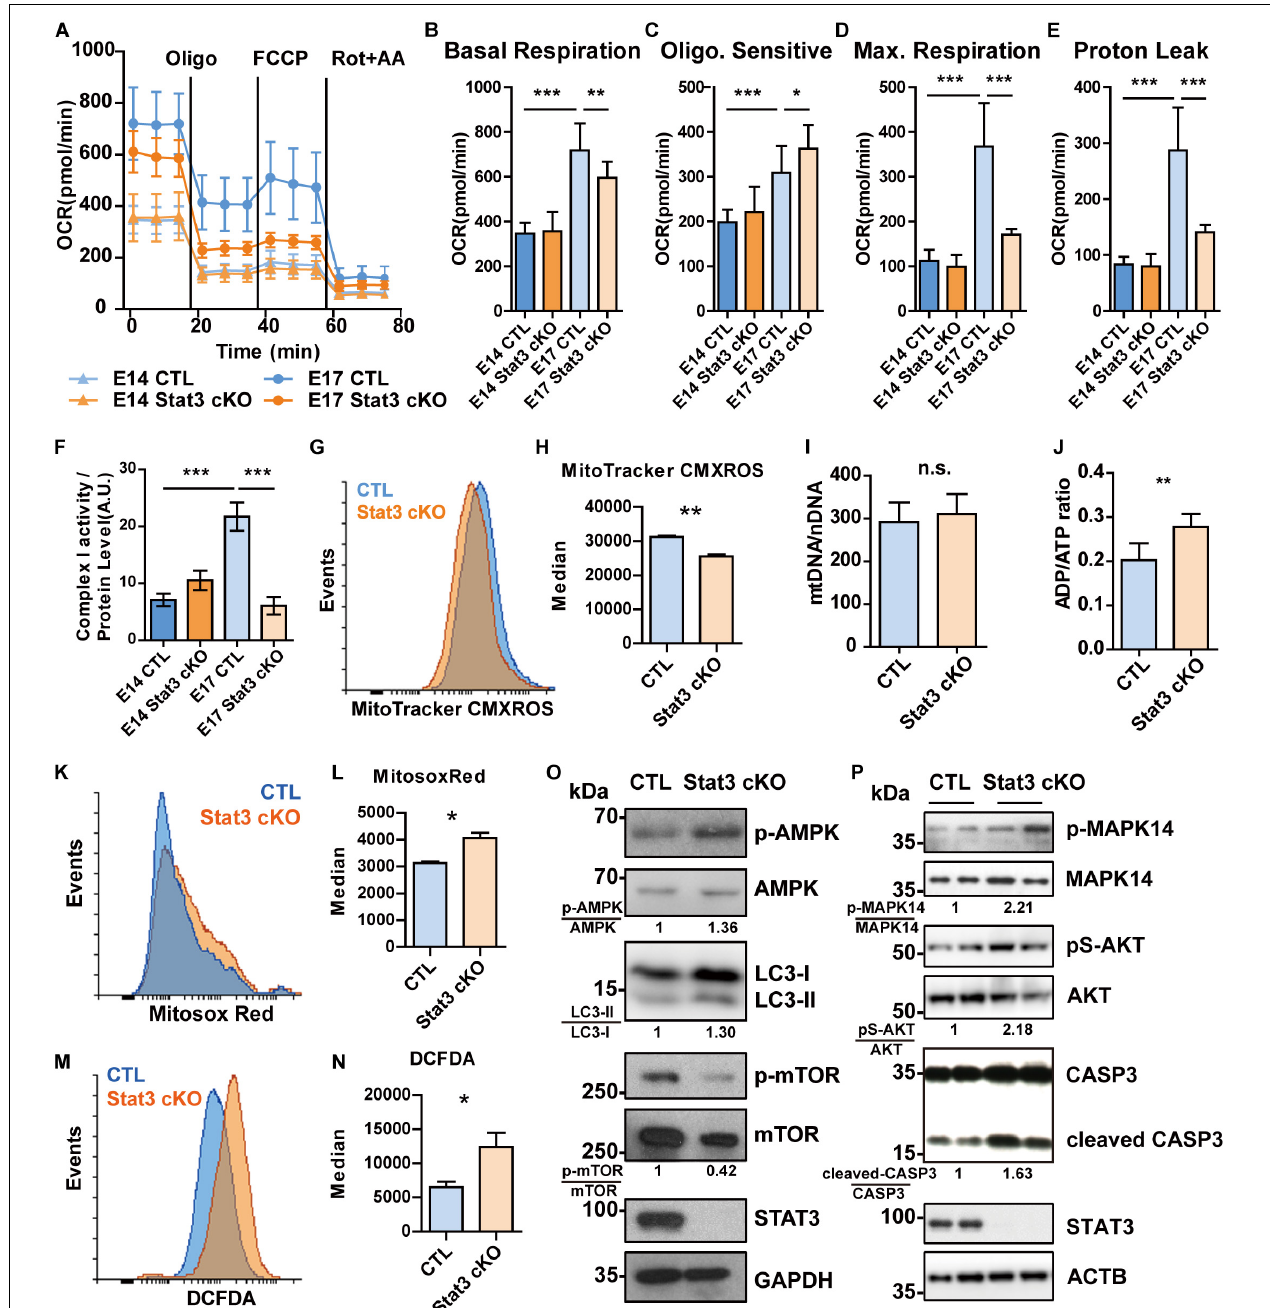
FIGURE 4 | STAT3 regulates mitochondrial respiration and ROS production in neural progenitors. (A–E) OCR of E14 neural progenitors was comparable between CTL and Stat3 cKO. But at E17, the OCR of Stat3 cKO was significantly decreased compared to the CTL. (F) The Complex I activity was compromised in E17 Stat3 cKO neural progenitors. (G,H) E17 Stat3 cKO neural progenitors had lower mitochondrial membrane potential indicated by MitoTracker CMXROS staining. (I) qPCR showed that the ratio of mitochondrial-DNA to nuclear-DNA is not significantly changed between CTL and Stat3 cKO neural progenitors. (J) ADP/ATP ratio assay showed that Stat3 cKO neural progenitors had elevated ADP/ATP ratio. (K,L) Flow cytometry showed that Stat3 cKO neural progenitors had increased mitochondrial superoxide production. (M,N) Flow cytometry showed that Stat3 cKO neural progenitors contained increased cellular ROS. (O) Western blot showed that Stat3 cKO neural progenitors had elevated AMPK pathway activation accompanied by decreased mTOR. (P) Stat3 cKO resulted in increased activation of MAPK14 and AKT, as well as increased CASP3 cleavage. Each lane was sample collected from individual embryo of the same little. Oligo, oligomycin; Rot, Rotenone; AA, antimycin A. Error bars represent mean ± standard deviations. * p < 0.05, ** p < 0.01, *** p < 0.005, n.s. not significant.